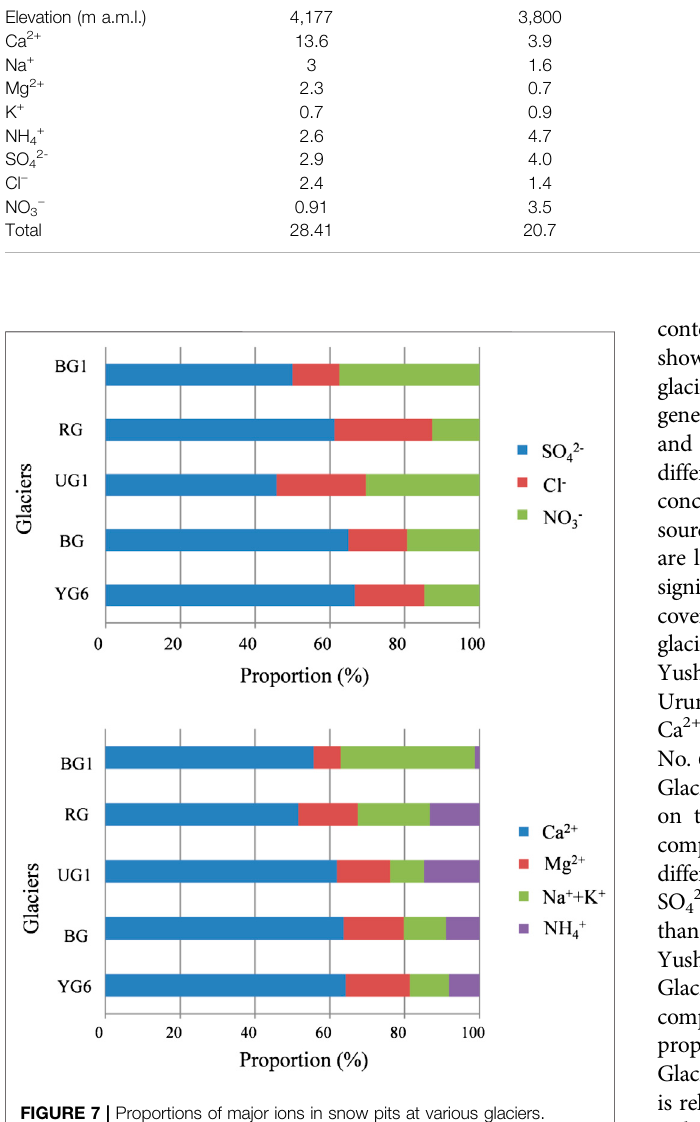
Elevation (m a.m.l.)